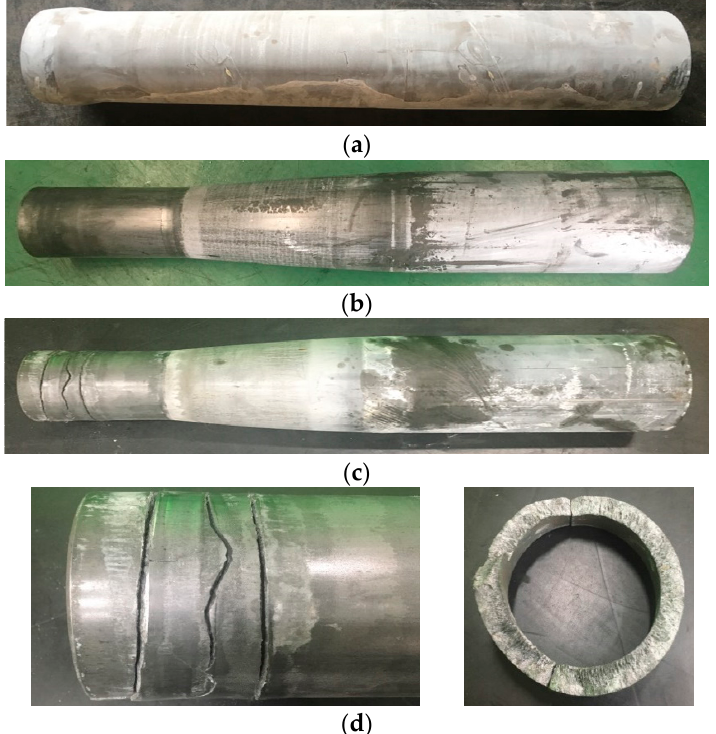
Figure 2. Materials in the cold shell nosing process experiments: ( a ) preform, ( b ) good-quality case, ( c ) fracture case, and ( d ) Expanded view of the fracture.